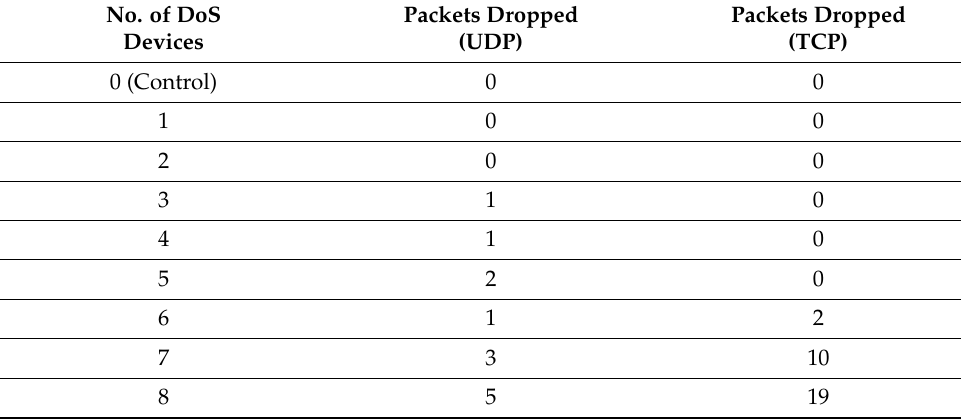
Table 12. Table displaying the total quantity of packets dropped across all the experiments run